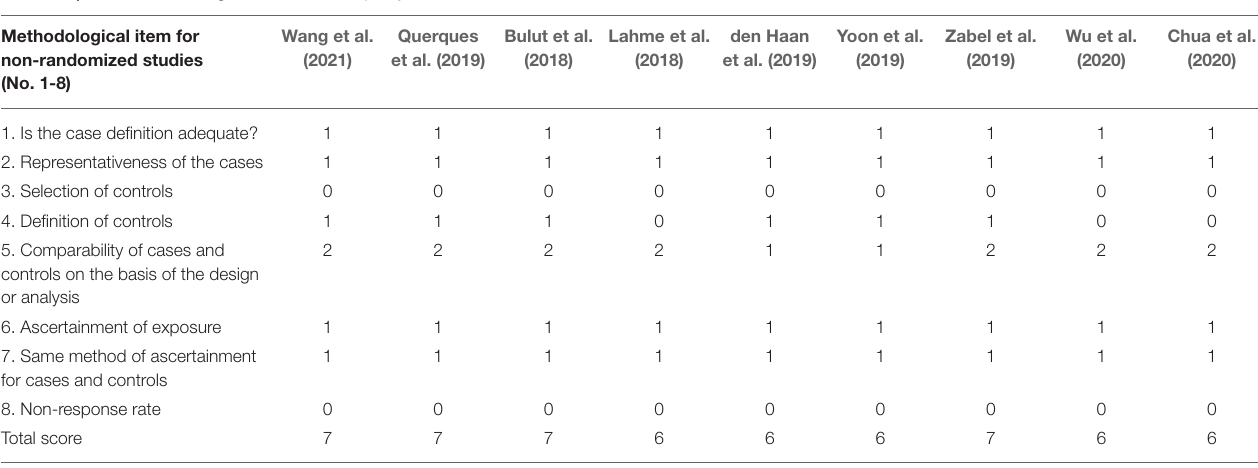
TABLE 2 | NOS for evaluating included studies